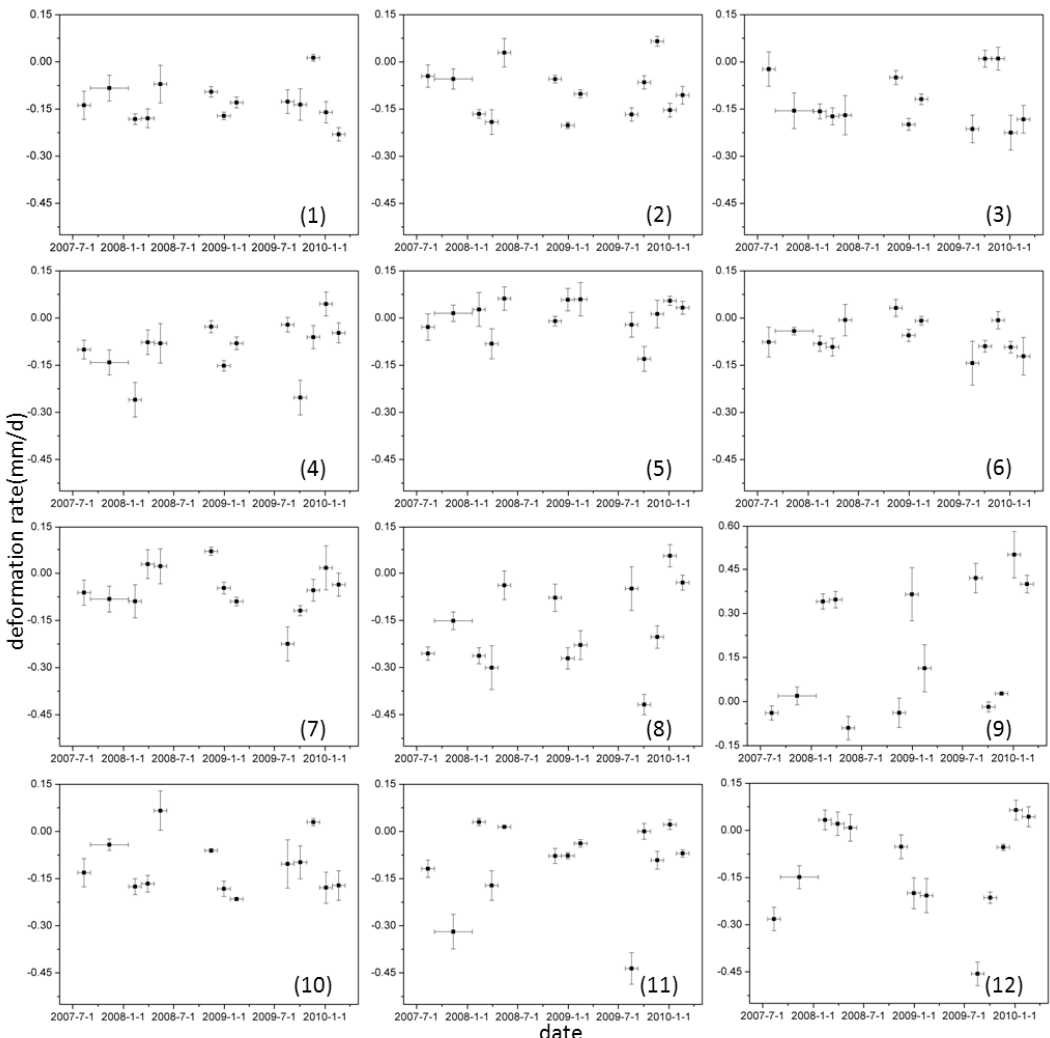
Figure 4. The time-series deformation rate of each creep body. The sequential number of each panel corresponds to the serial number of the creep body. Vertical error bars represent the standard deviation of the deformation rate for the selected area within each creep body, while horizontal bars indicate the duration of the deformation period defined by two adjacent SAR acquisitions.